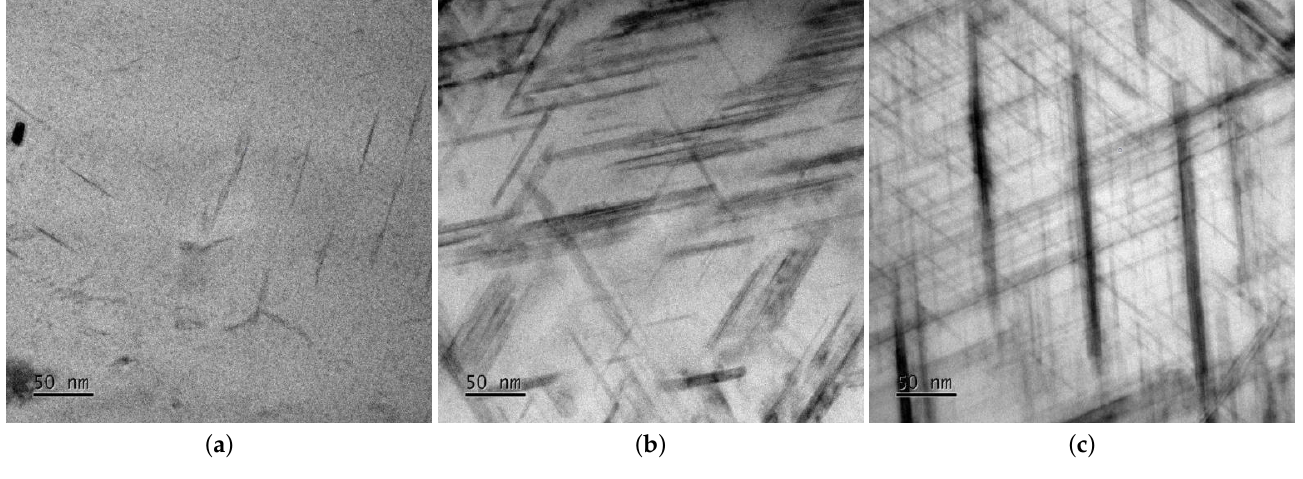
Figure 7. TEM images of intragranular precipitates in SiCp–AA2009 composites under ( a ) CHT-UA (CHT with 4 h ageing); ( b ) CHT-PA (CHT with 20 h ageing); and ( c ) DCT-PA (DCT with 20 h ageing).